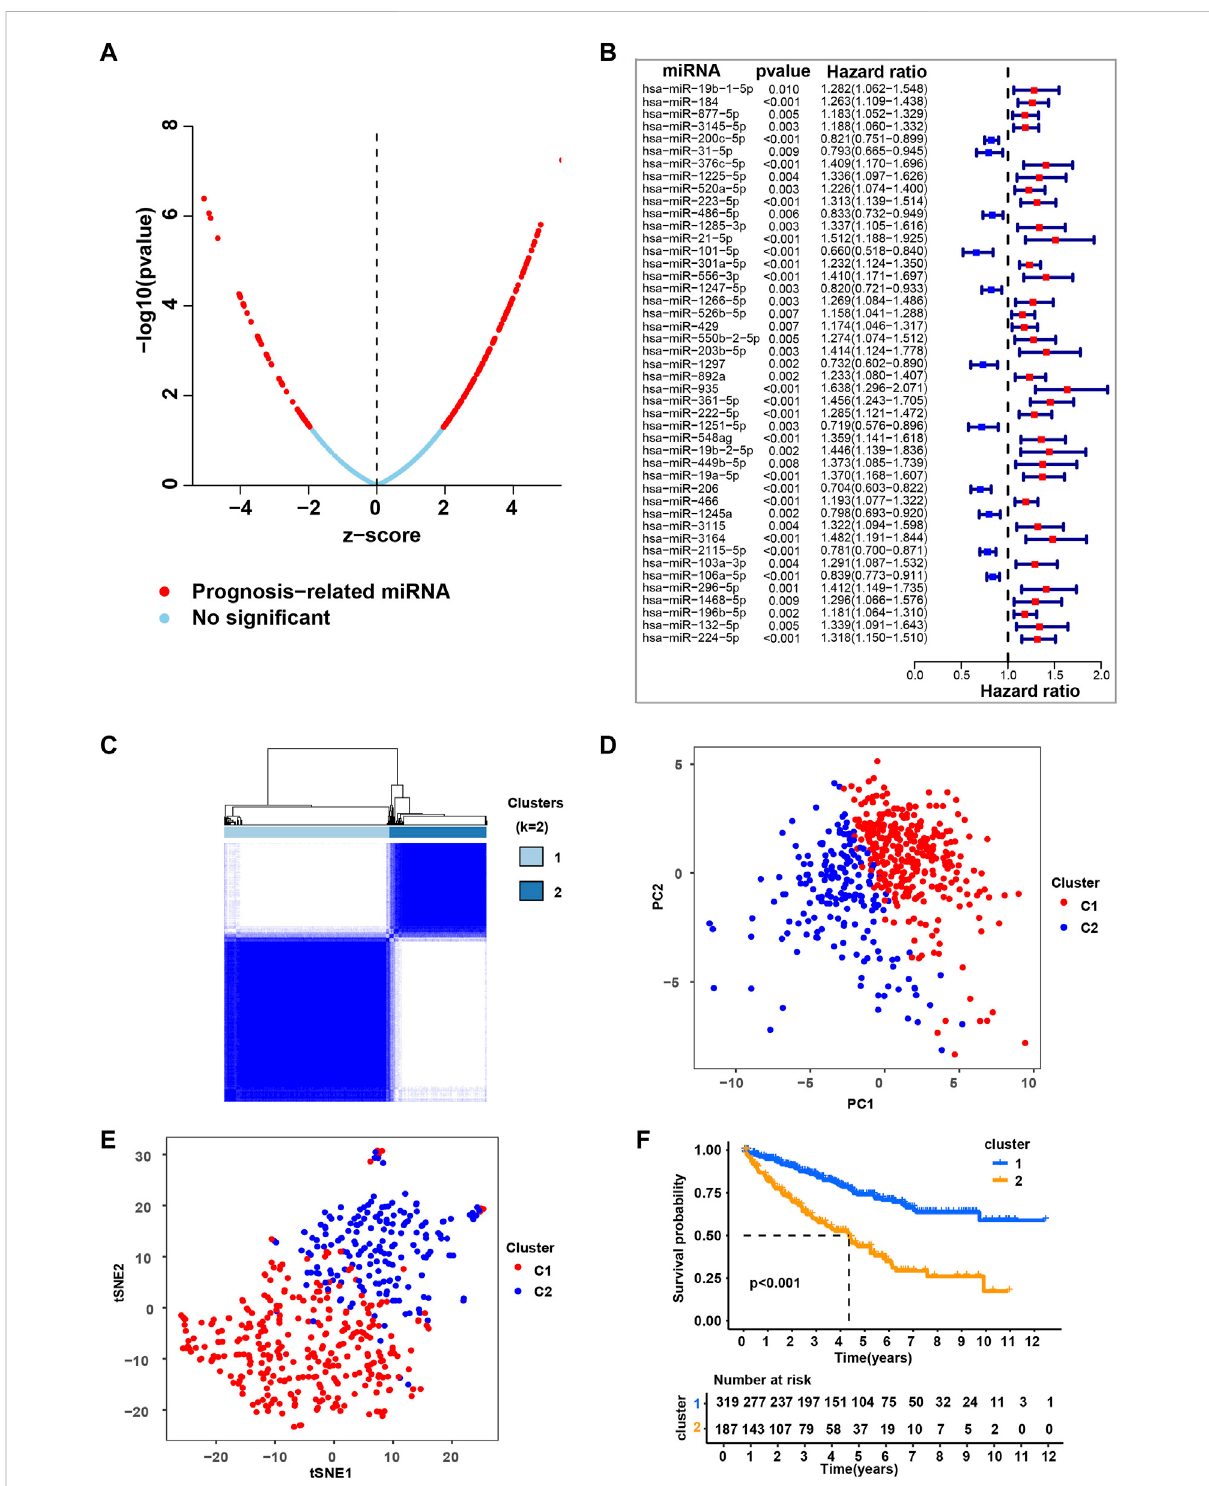
FIGURE 1 Consensus clustering based on the independent prognosis-related miRNAs for ccRCC. (A) Univariate cox regression analysis to identify the prognosis-relatedmiRNAs(pr-miRNAs)inccRCC. (B) Multivariatecoxregressionanalysistoidentifytheindependentprognosis-relatedmiRNAs(ipr- miRNAs) in ccRCC. (C) Consensus matrix heatmap when k = 2. Related to Supplementary Figure S2. (D) Principal component analysis (PCA) for the TCGA-retrieved ccRCC patients, each dot represents a single sample. (E) T-distributed stochastic neighbor embedding (t-SNE) analysis for the TCGA-retrievedccRCCpatients,eachdotrepresentsasinglesample. (F) Kaplan-MeierplotanalysisfortheindicatedTCGA-retrievedccRCCpatients distributed in Cluster1 (C1) and Cluster2